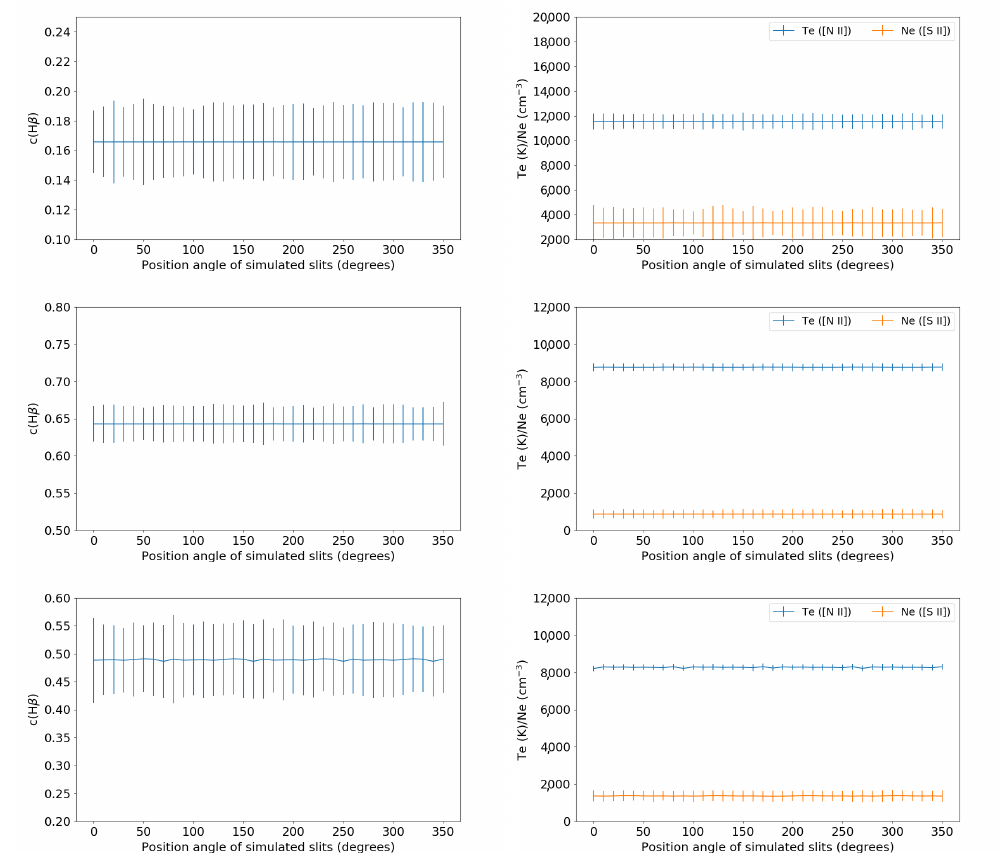
Figure 1. Interstellar extinction coefficient c(H β ) ( left panels ), electron temperature ( T e , blue points), and density ( n e , orange points) ( right panels ) of NGC 7009 ( upper ), NGC 6778 ( middle ), and Hen 2- 108 ( lower panels ) as functions of the position angle (PA) of the rectangular aperture that covers the whole nebulae (64 × 64 arcsec, 67 × 67 arcsec, 40 × 40 arcsec). The vertical lines indicate the error bars of each